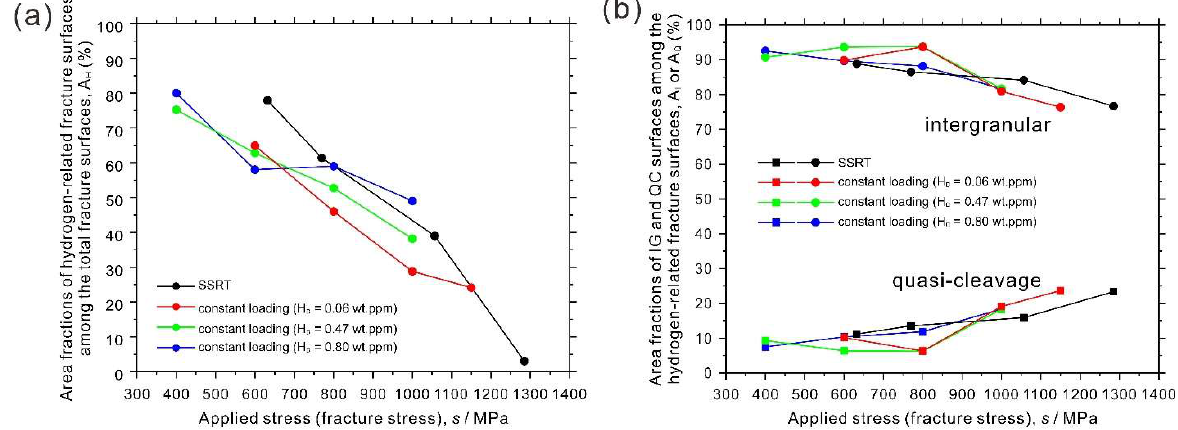
Figure 6. ( a ) Area fractions of hydrogen-related fracture surfaces among the total fracture surfaces as a function of applied stress in the constant loading tensile test and fracture stress in the slow strain rate tensile test. ( b ) Area fractions of intergranular and quasi-cleavage surfaces among the hydrogen-related fracture surfaces as a function of applied stress in the constant loading tensile test and fracture stress in the slow strain rate tensile test. Each plot of the slow strain rate tensile test had a different H D .